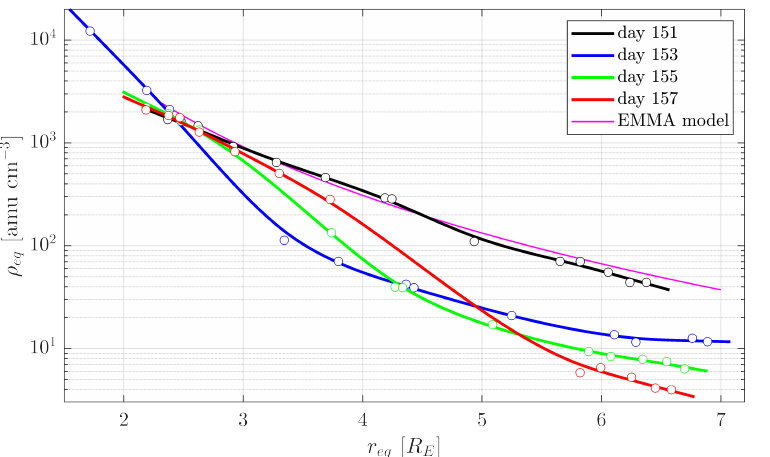
Figure 6. Radial plasma density profiles on days 151, 153, 155 and 157, at 09:00 MLT. The open circles are density estimated by the EMMA pairs. The solid curves are the fit profiles. The magenta curve is the plasmasphere model by Del Corpo et al. [52], which is a good representation of the saturated